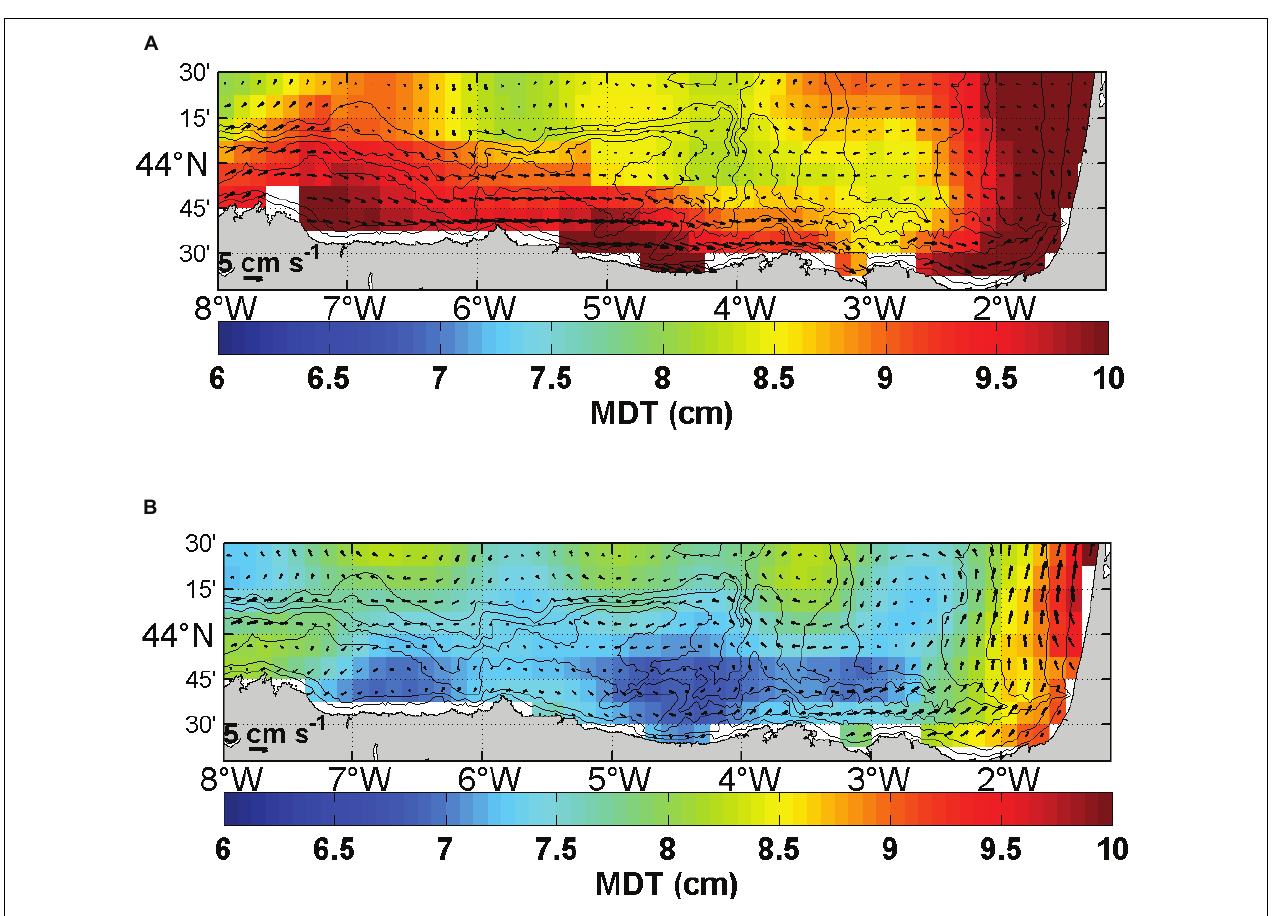
FIGURE 9 | Zoom of the coastal (A) and CNES-CLS18 MDT (cm) and the corresponding geostrophic currents (B) .